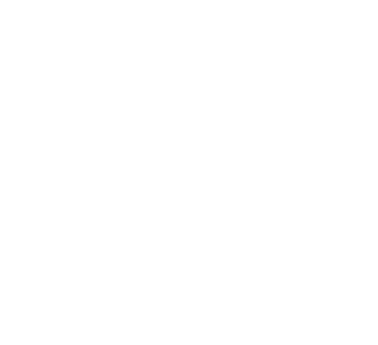
Figure 1. Diagrams describing the TH reaction 2 H( 3 He,pt)H in the QF kinematics, proceeding through the direct 3 He(n,p) 3 H